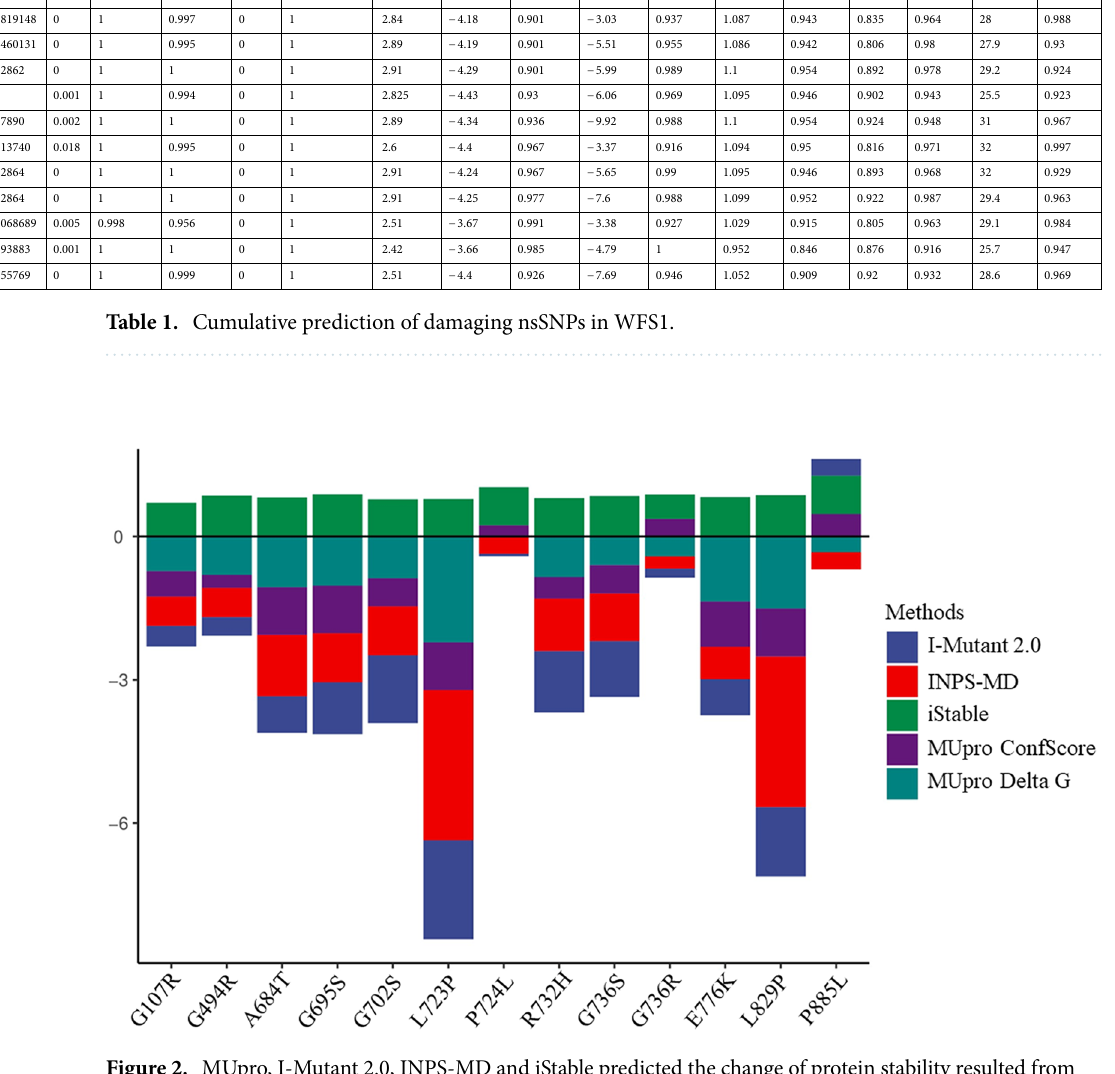
Figure 2. MUpro, I-Mutant 2.0, INPS-MD and iStable predicted the change of protein stability resulted from